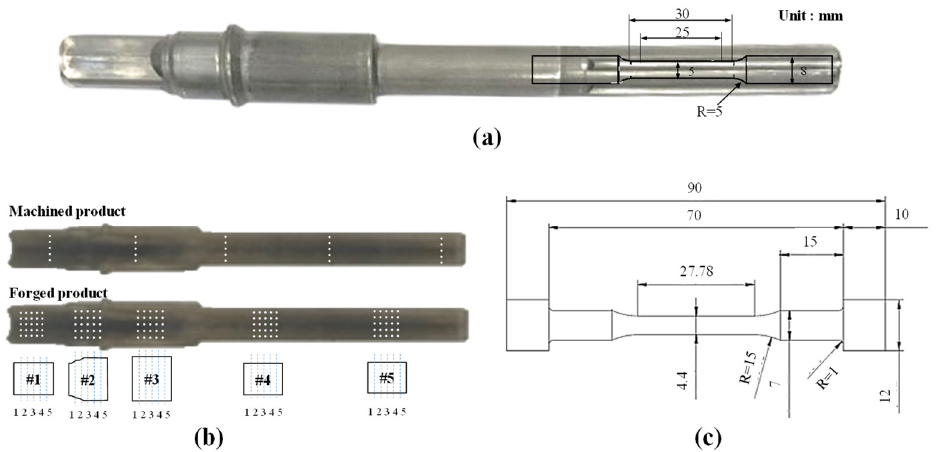
Figure 3. ( a ) Dimension of tensile test specimen, ( b ) data acquisition points for the Vickers micro-hardness test, and ( c ) dimensions of the specimen for the fatigue test.